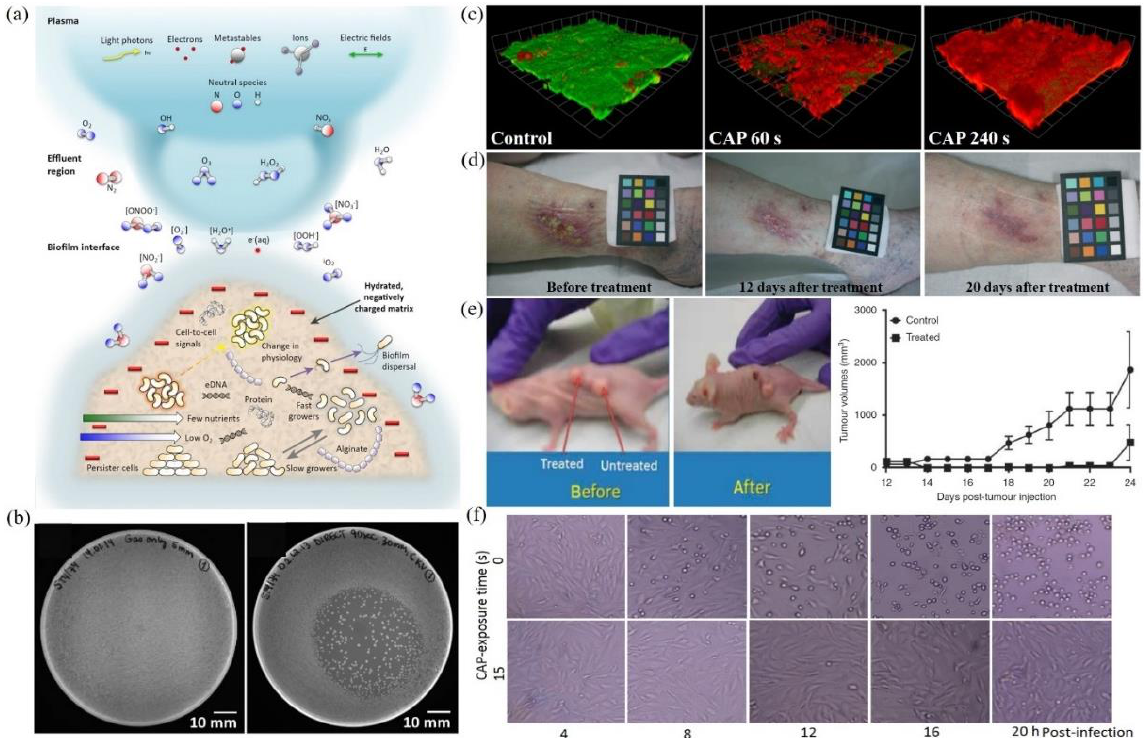
Figure 2. A general picture of plasma medicine. ( a ) Schematic illustration of the biological effect of CAP. Here, biofilm was used as an example [26]. ( b ) Growth inhibition of CAP source (DBD) on bacteria (S. Typhimurium) grown on LB agar plates: control (left) and DBD treatment (right) [31]. ( c ) Confocal scanning laser microscopic imaging of strong bacterial death in a CAP-treated biofilm grown on polycarbonate coupons. Live cells and dead cells were present in green and red, respectively [30]. ( d ) The improved wound healing of the inflamed ulcer on a human leg by CAP treatment [39]. ( e ) Tumor inhibition effect of CAP jet treatment on subcutaneously xenografted bladder tumor on mice [8]. ( f ) The inactivation of feline calicivirus and the inhibited infectivity on its host Crandell-Reese feline kidney cells by CAP treatment [48].